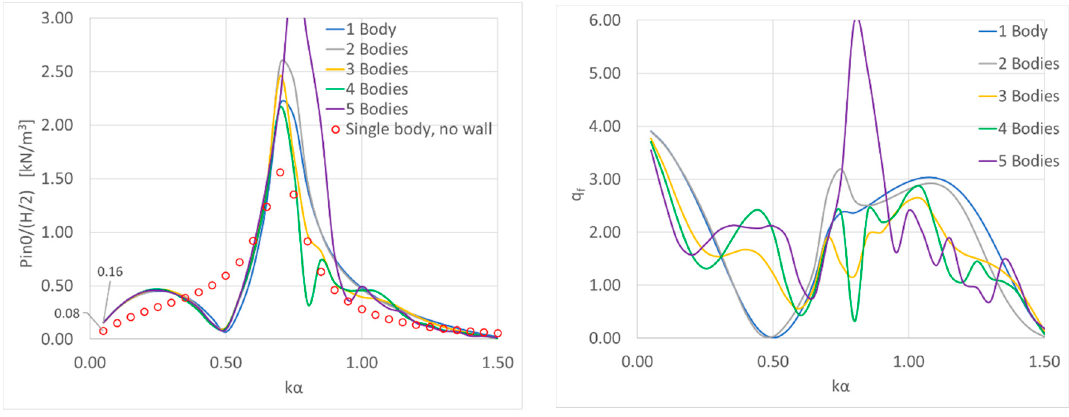
Figure 5. Air pressure inside the 1st OWC (left column figures) and array’s q f factor (right column figures) versus k α for various examined wave heading angles: ( a ) β = 0; ( b ) β = π /6; ( c ) β = π /4. Perpendicular arrangement.